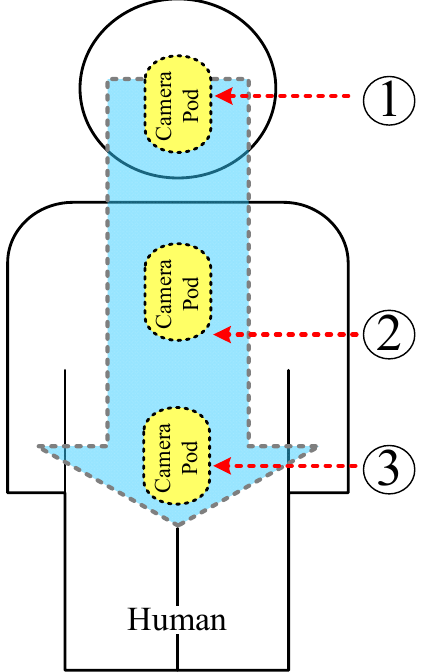
Table 4. Comparison of the optimization algorithms.